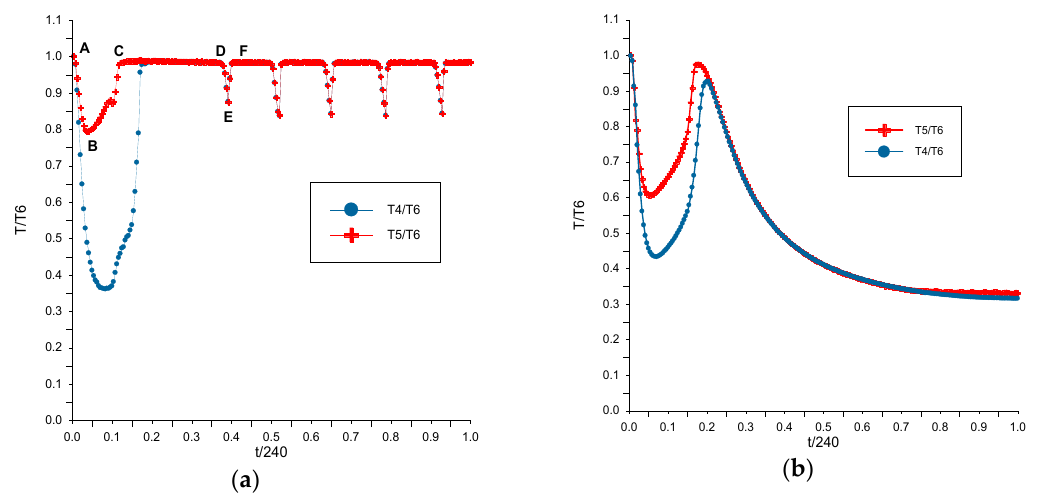
Figure 6. T5/T6 and T4/T6 values vs. non-dimensional time t/240 (240 min heating interval): ( a ) S+DS; ( b ) B+DS.